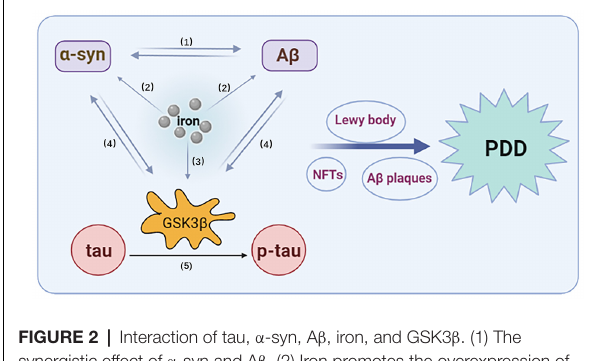
FIGURE 2 | Interaction of tau, α -syn, A β , iron, and GSK3 β . (1) The synergistic effect of α -syn and A β . (2) Iron promotes the overexpression of α -syn and A β . (3) Iron promotes the activation of GSK3 β . (4) α -Syn and A β can promote an increase in GSK3 β , which can, in turn, promote the expression of α -syn and A β . (5) GSK3 β promotes the phosphorylation of tau. nuclei, and locus coeruleus (Braak et al., 2006; Brundin and Melki, 2017). Astrocytes, which are the most abundant glial